Question: Summarize what this figure shows in one sentence.
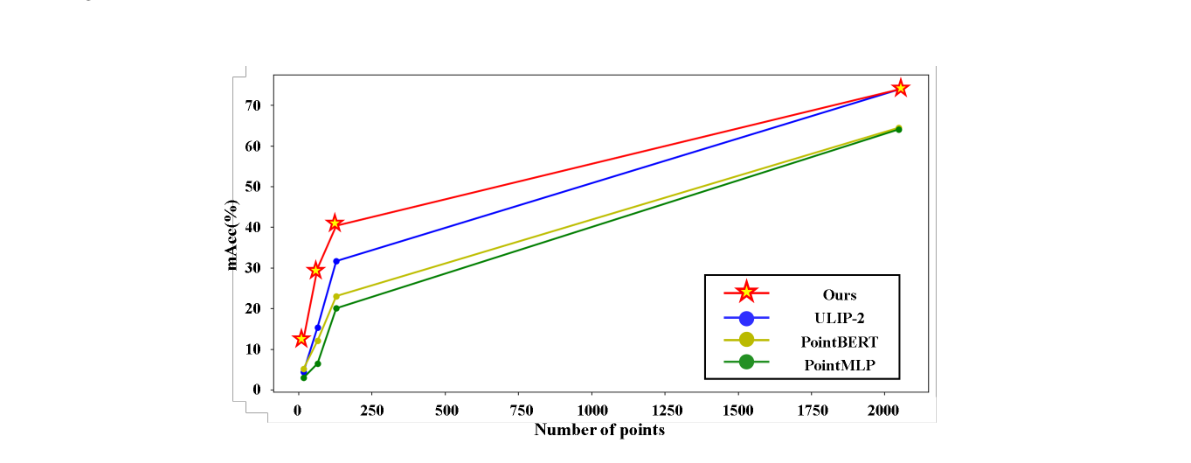
Answer: Zero-shot classification accuracy on the ModelNet-40 dataset. Our approach dramatically increases the zero-shot capability on the extremely sparse point clouds.